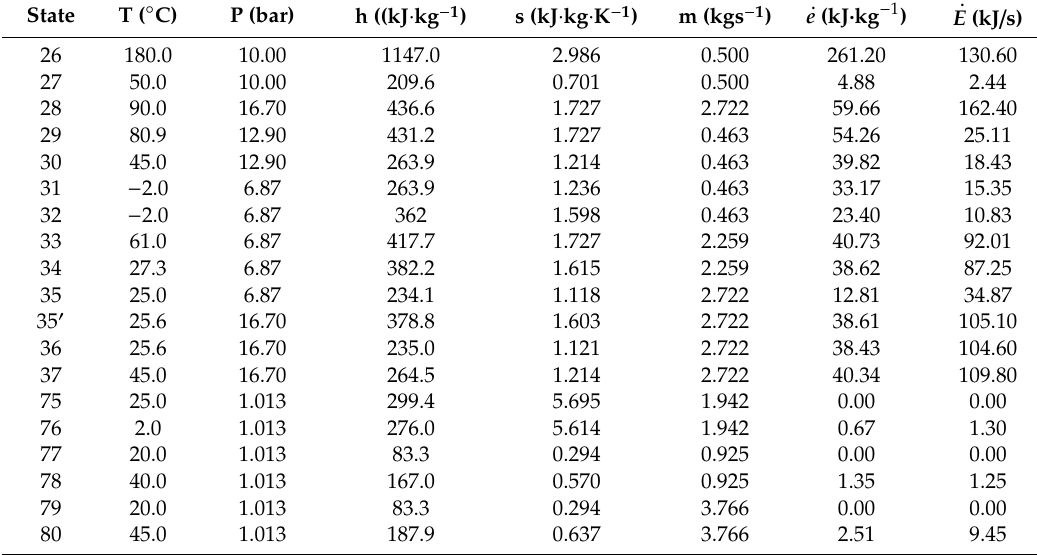
Table A5. Thermodynamic state points properties for the organic Rankine cycle in the